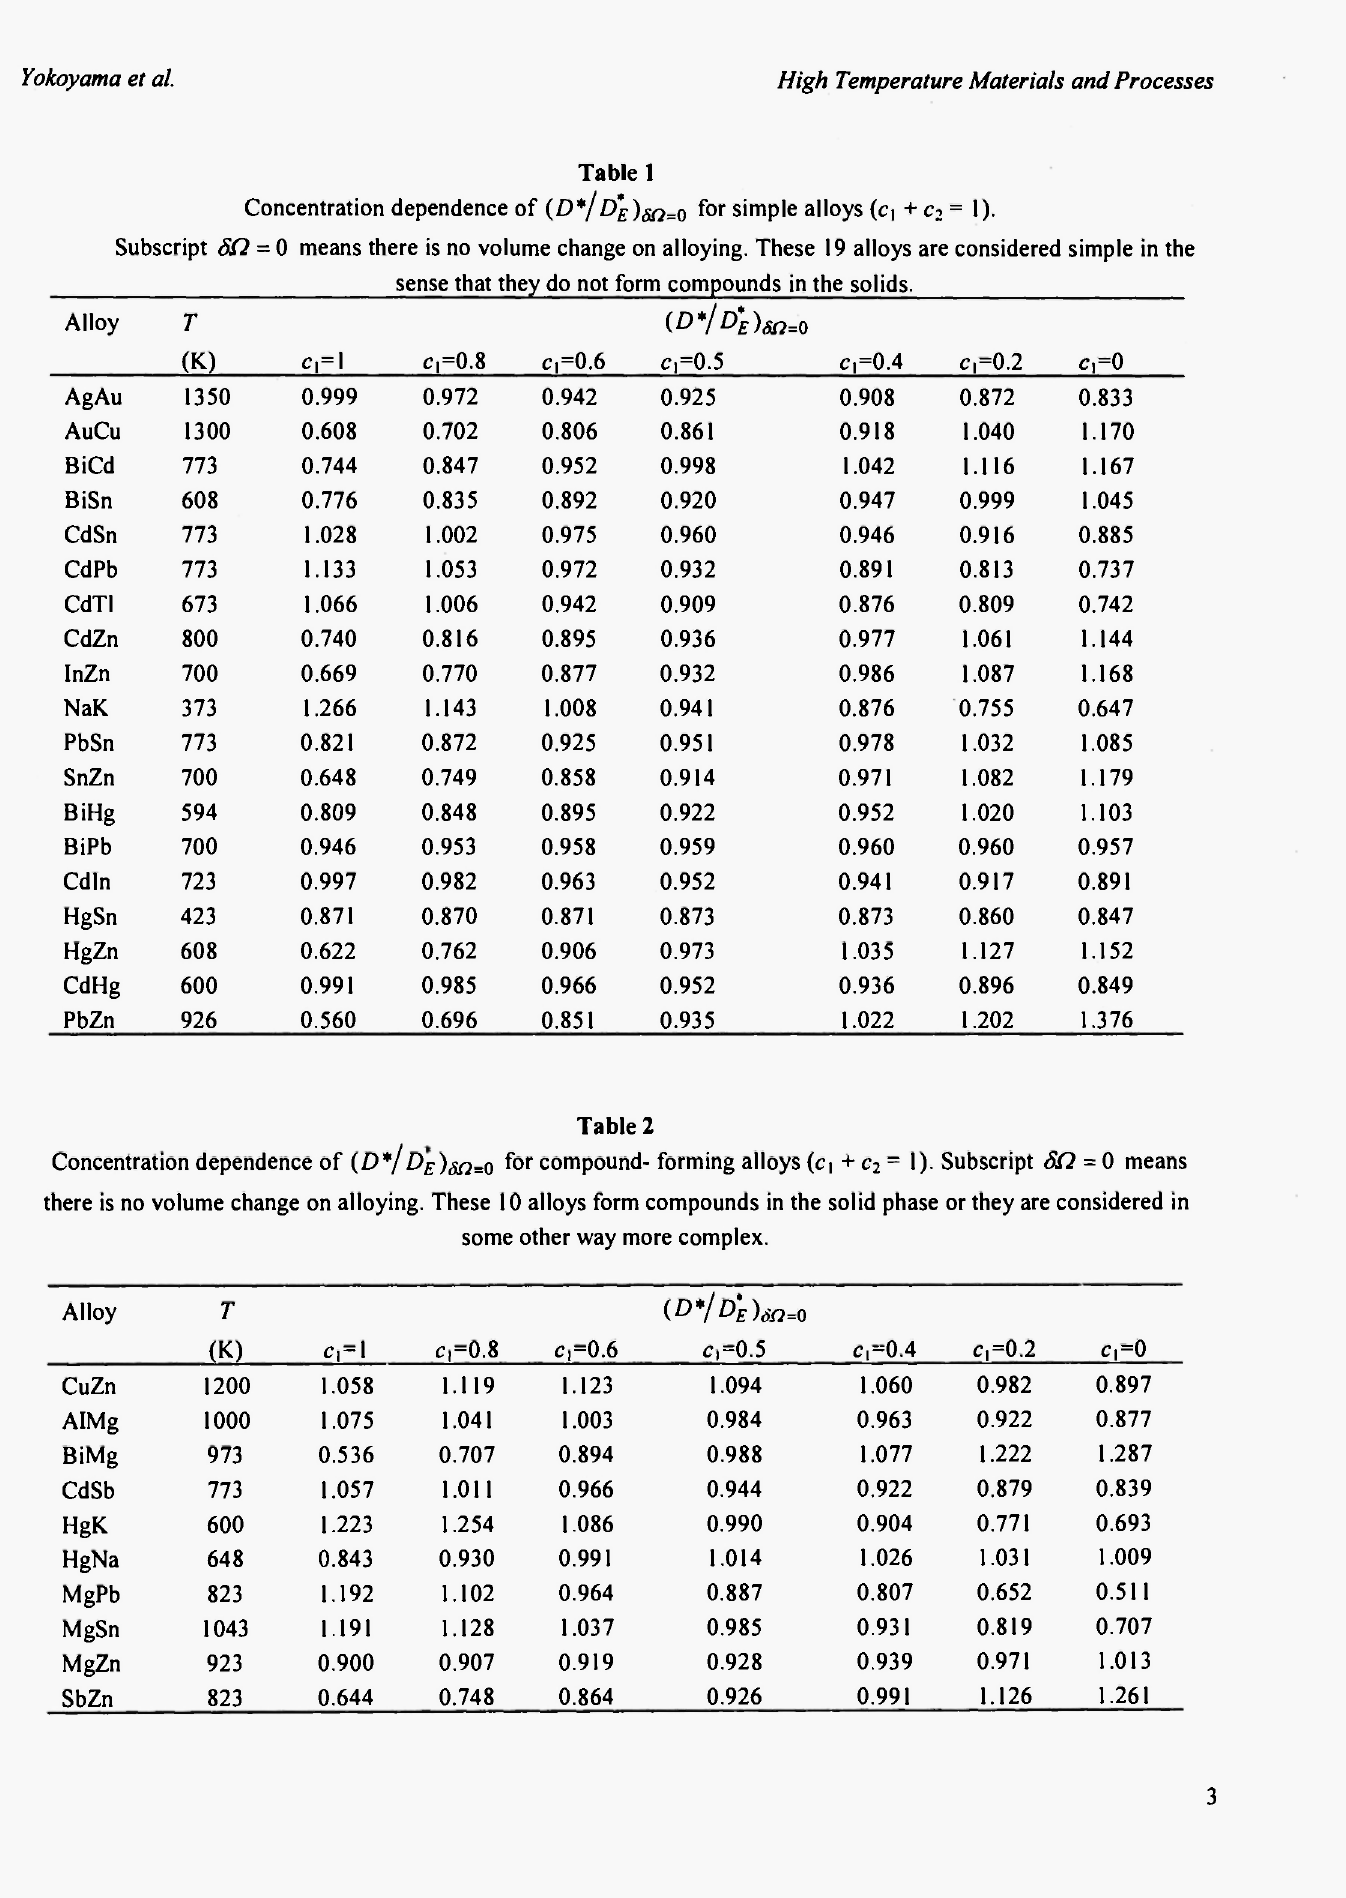
Concentration dependenceof {D*/D* E )gQ = 0 for simple alloys (c, + c 2 = 1).